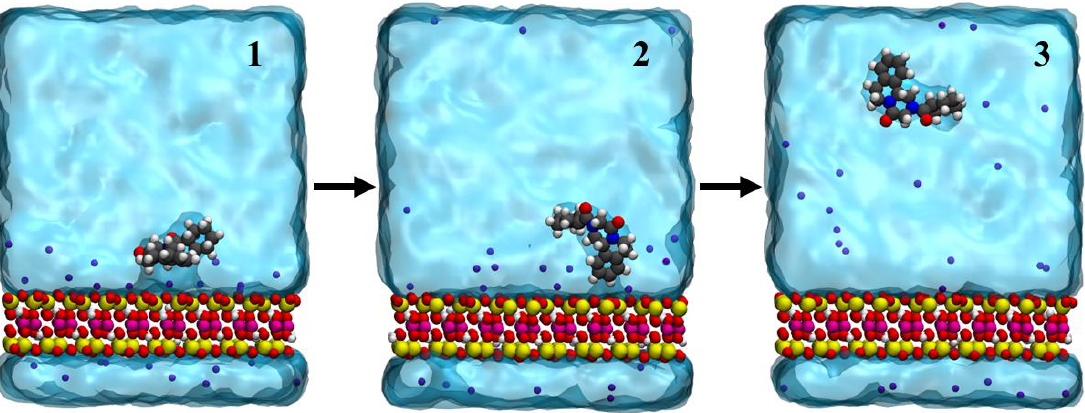
Figure 4. Desorption of praziquantel from montmorillonite surface in aqueous solution, obtained from standard molecular dynamics simulations.